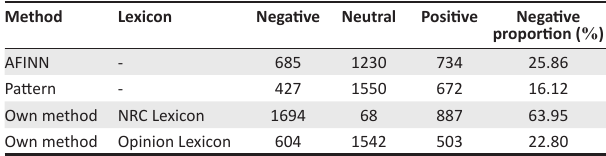
TABLE 6: Results of the sentiment analysis (without retweets, n = 2649).